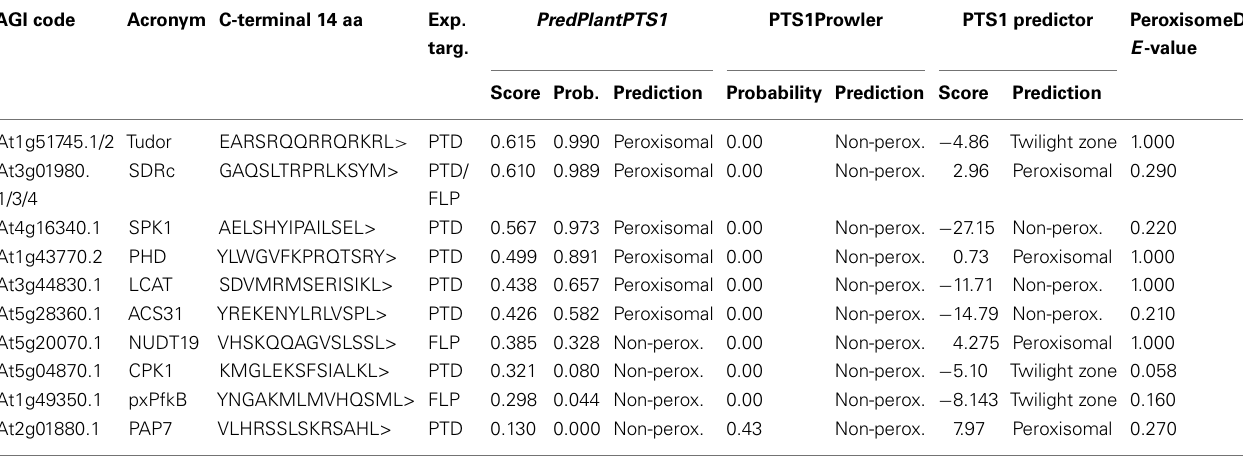
Table 1 | Comparative PTS1 protein prediction of experimentally validated Arabidopsis proteins carrying non-canonical PTS1 tripeptides by different web